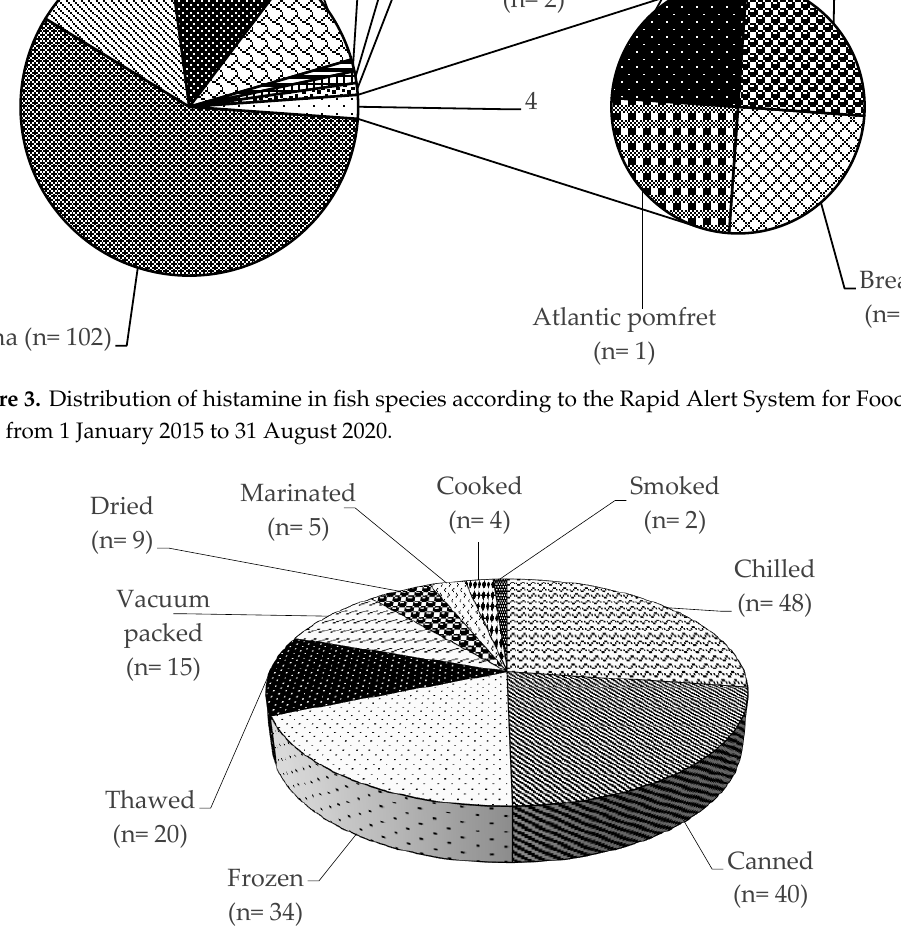
Legend: * information for attention; ** border rejection.